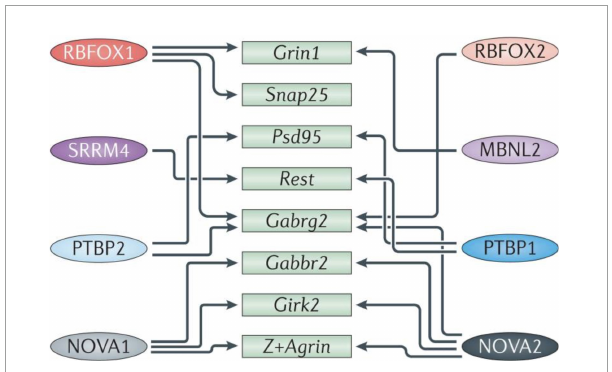
FIGURE2 Diagram representing some of the splicing mechanisms in the brain. Numerous transcripts important in brain and neurological development (green boxes) are cross-regulated (indicated by arrows) by multiple RNA-binding proteins (RBPs; colored ovals on the left and right ). Girk2, inwardly rectifying potassium channel Kir3.2; Gabrg2, GABAA receptor subunit gamma 2; Gabbr2, GABAB receptor 2; MBNL, muscleblind-like; NOVA, neuro-oncological ventral antigen; Psd95, postsynaptic density protein 95; PTBP, polypyrimidine tract binding protein; Rest, repressor element 1-silencing transcription factor; RBFOX, RNA-binding protein fox 1 homolog; Snap25, synaptosome-associated protein 25; SRRM4, serine/arginine repetitive matrix protein 4. Figure from Vuong et al. (2016) obtained by Springer Nature under license No